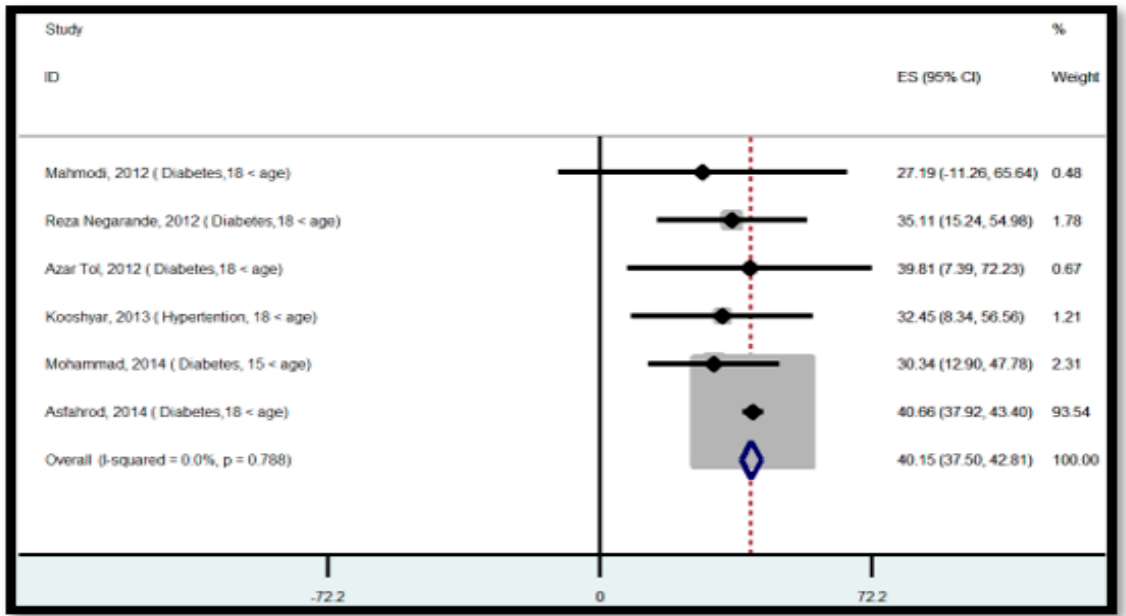
Figure 3. Forest plot of the distribution of effect size for health literacy status from 2012 to 2014, ES: effect size, I 2 : a measure of the ratio of the total variation in study measures due to heterogeneity, p > 0.05: devastates heterogeneity is appropriate for interpretation.